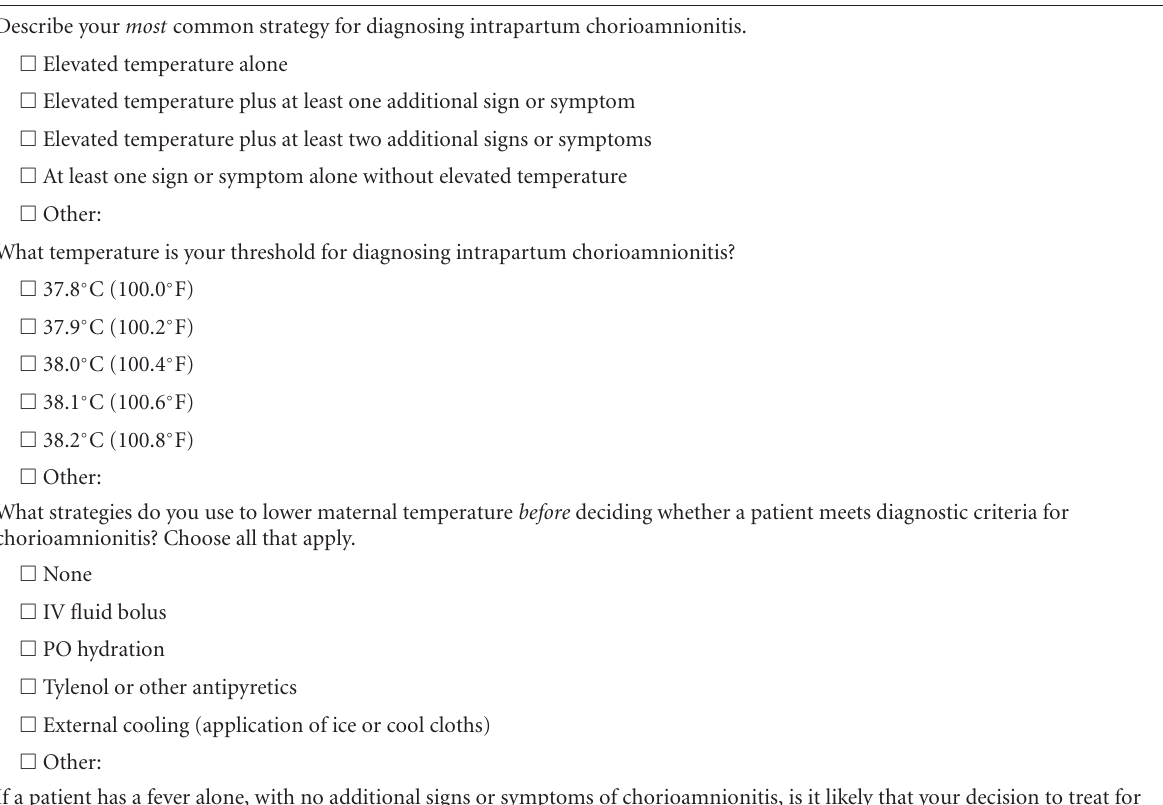
Table 1: Questions on diagnostic and treatment